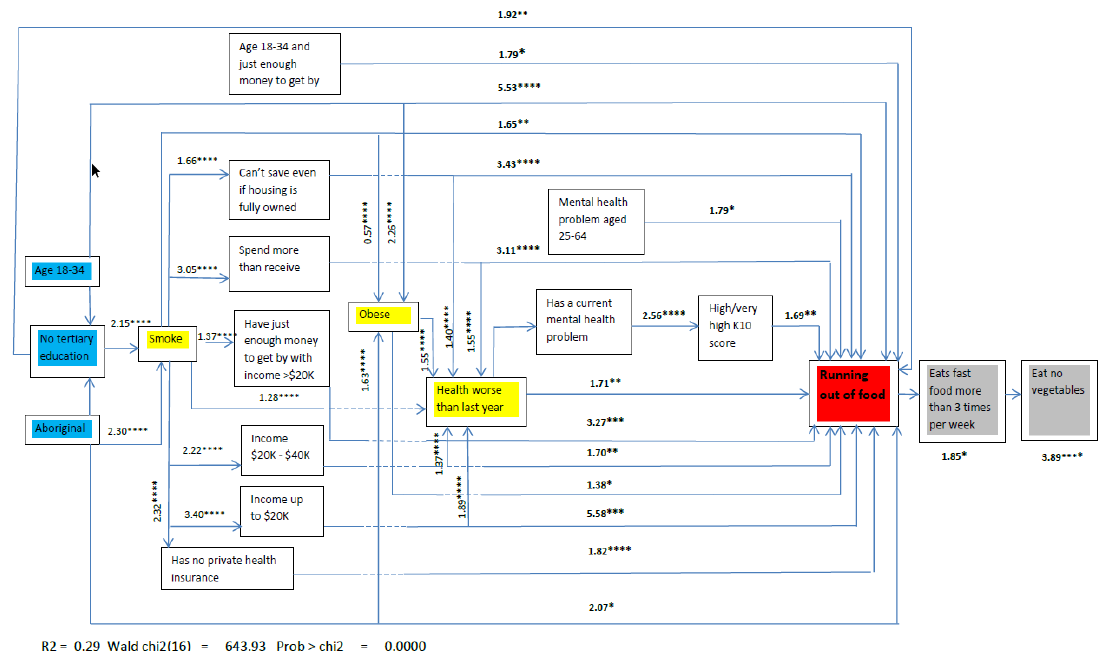
Figure 1. Estimate of probability of eating fast food more than twice a week and eating no vegetables by ‘running out of food’, adjusted using propensity scores: Showing probable outcomes of ‘running out of food’, HWSS 2009–2013. * p < 0.05; ** p < 0.01; *** p < 0.001; **** p < 0.0001.